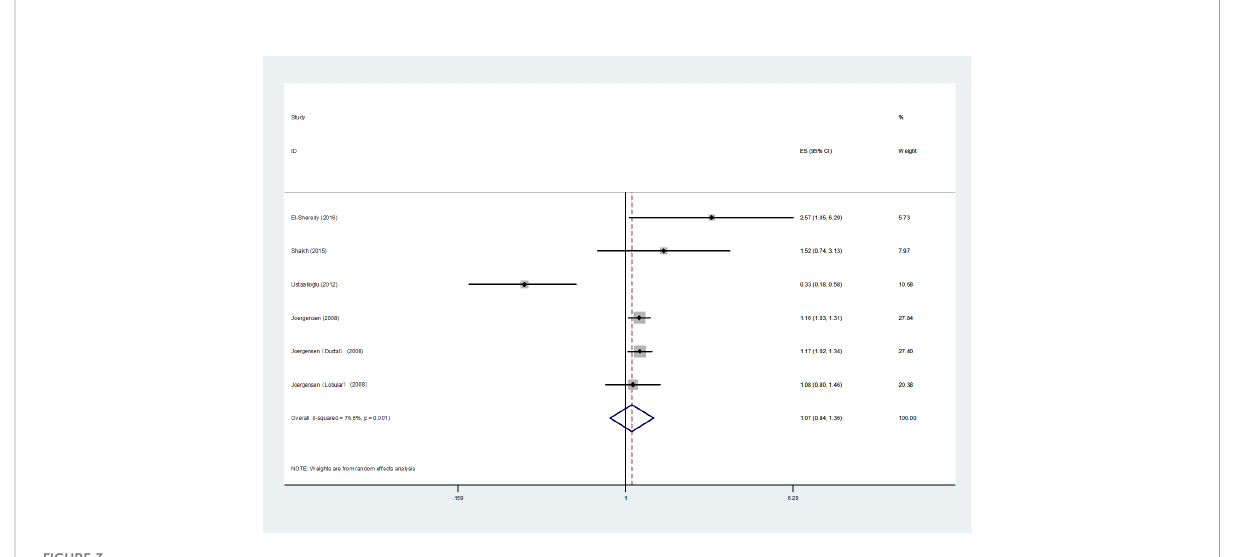
FIGURE 3 Forest plot of DFS comparing MMBC and